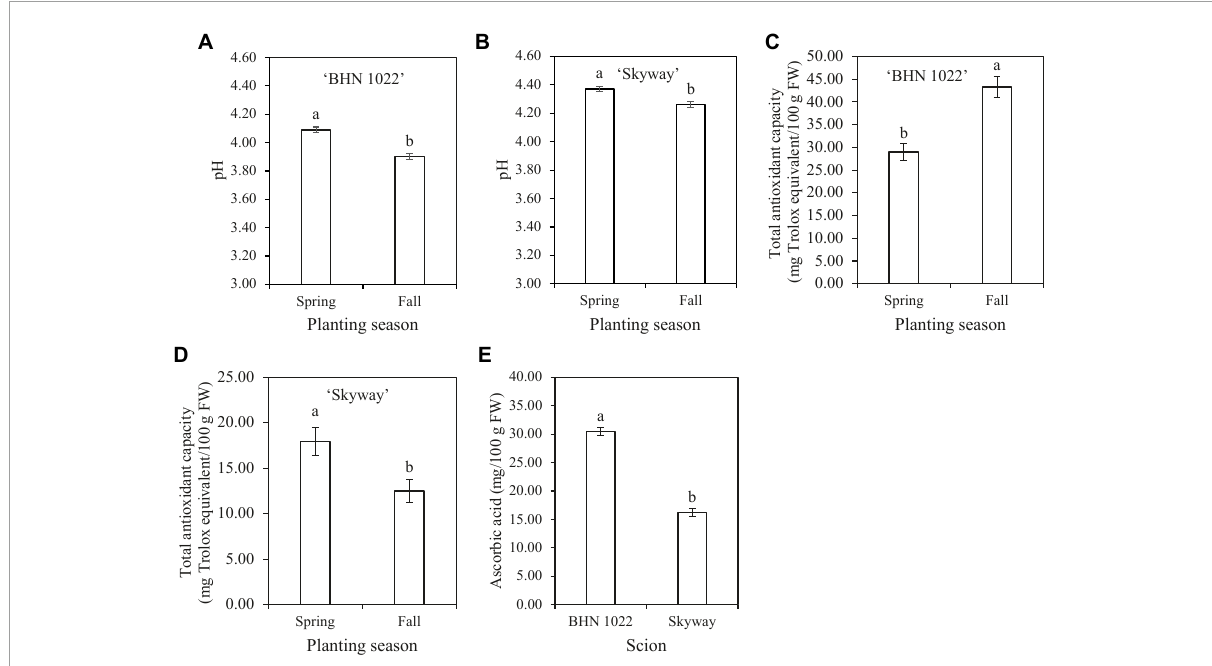
FIGURE2 Tomato fruit pH, total antioxidant capacity, and ascorbic acid content as affected by scion or scion × planting season interaction. (A) pH of ‘BHN 1022’ grape tomato fruit. (B) pH of ‘Skyway’ beefsteak tomato fruit. (C) Total antioxidant capacity of ‘BHN 1022’ fruit. (D) Total antioxidant